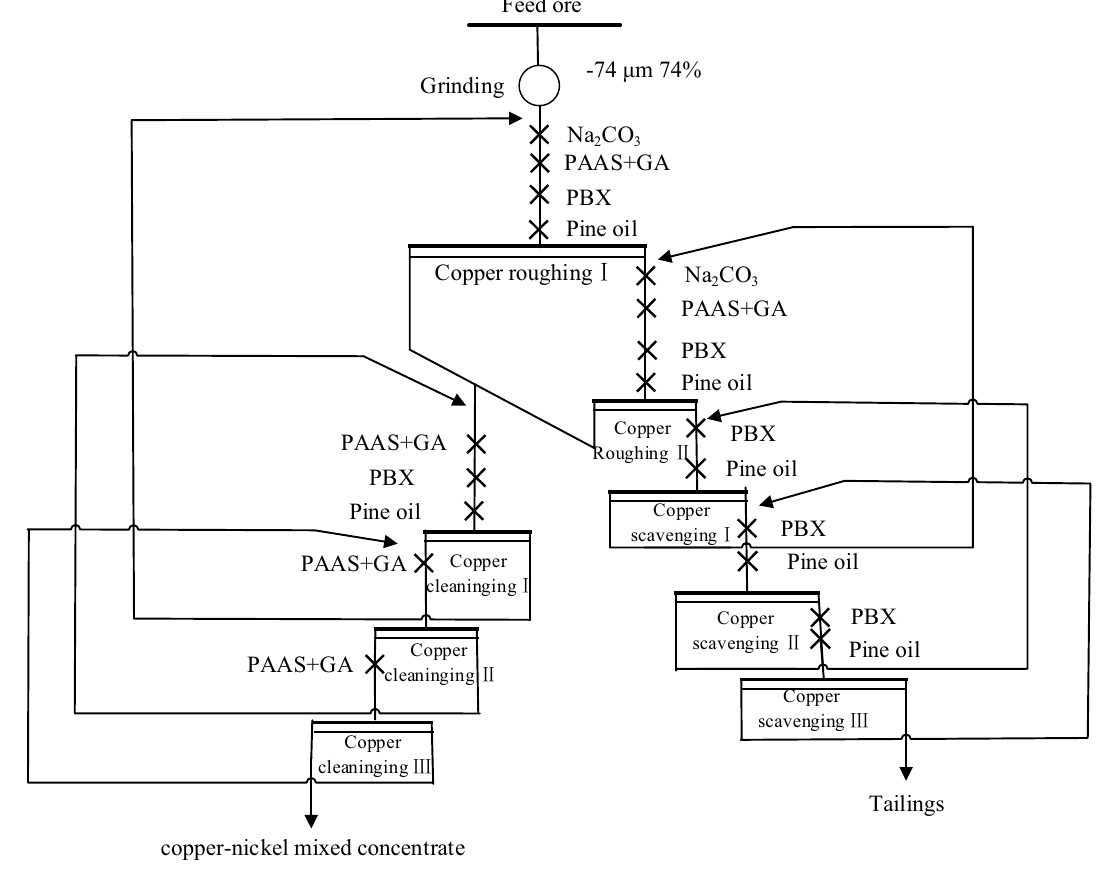
Figure 2. The flowsheet of laboratory closed-flotation operation for copper sulphide ore.